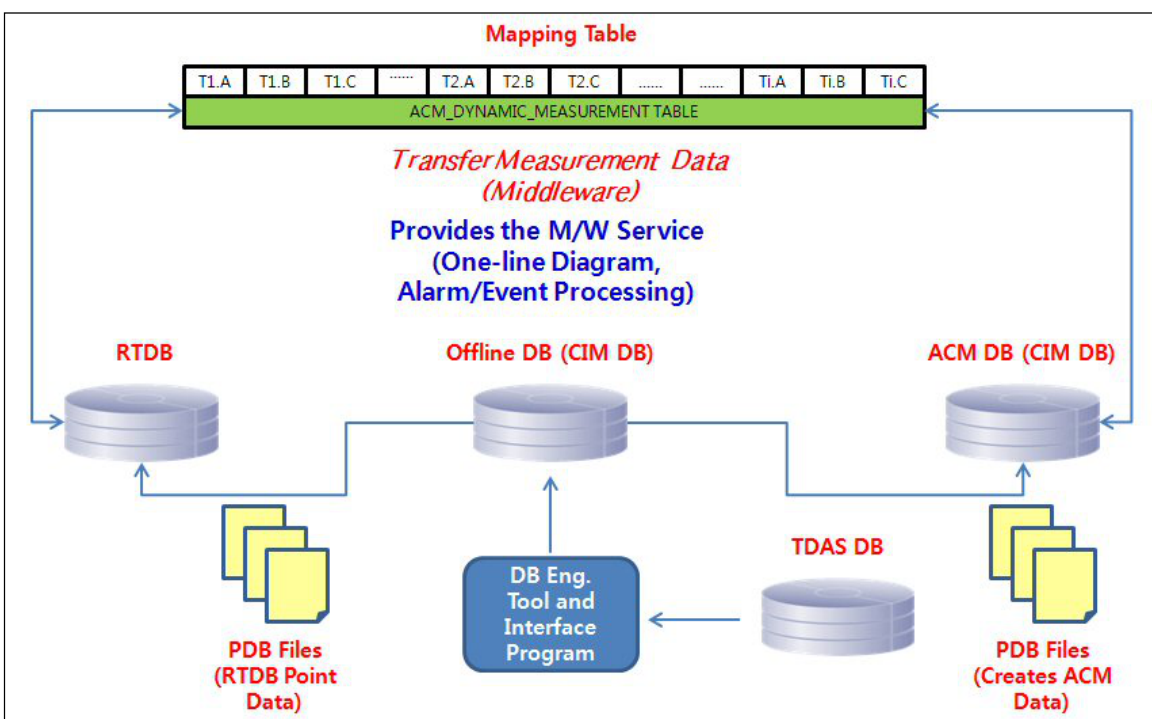
Figure 7. Relationship between RTDB and